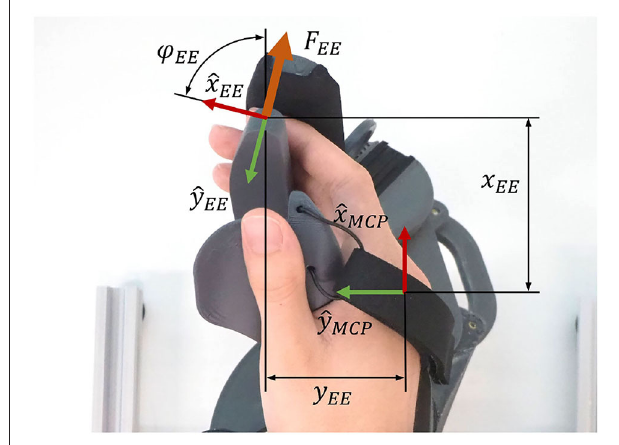
FIGURE 7 | End-effector and MCP joint positions.